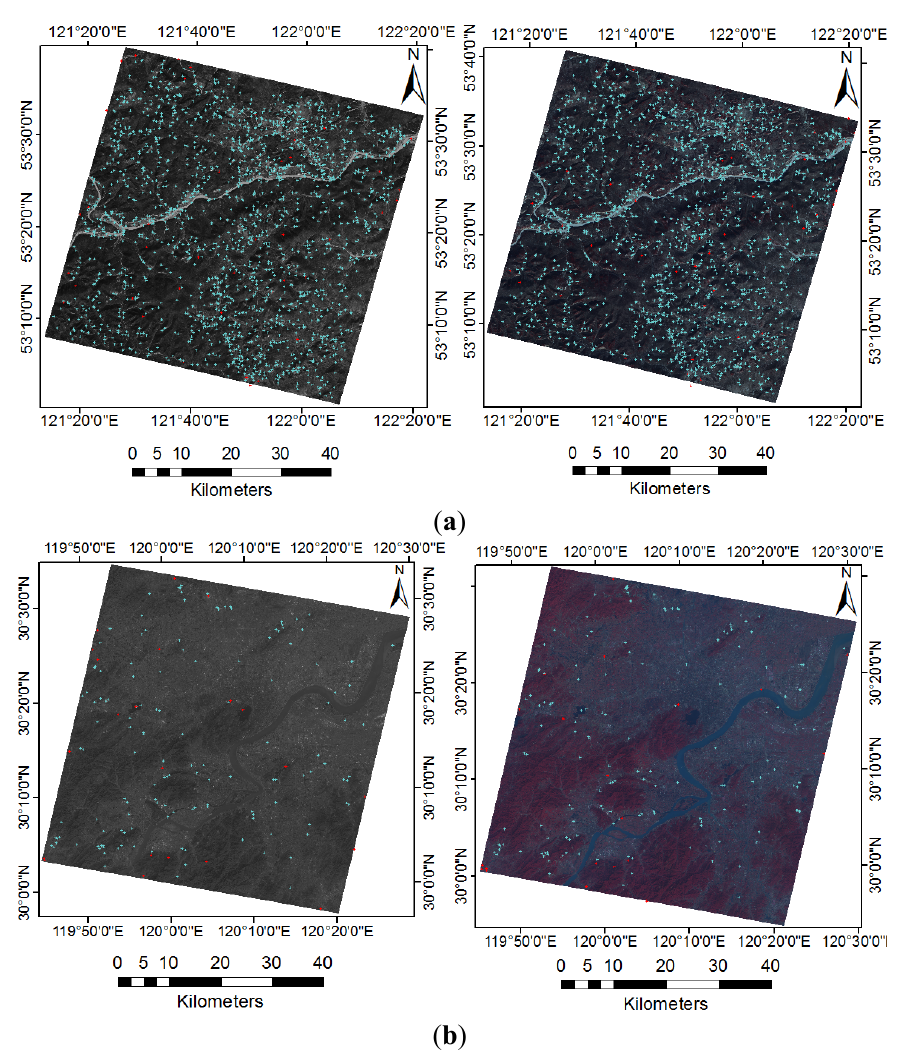
Figure 4. Results of SIFT matching on subsampled images. Blue crosses indicate estimated points and red crosses indicate excluded points. ( a ) Dataset 1. 1,941 pairs of corresponding points were matched, of which 41 pairs were false matches. ( b ) Dataset 2. 163 pairs of corresponding points were matched, of which 22 pairs were false matches. ( c ) Dataset 3. 308 pairs of corresponding points were matched, of which 20 pairs were false